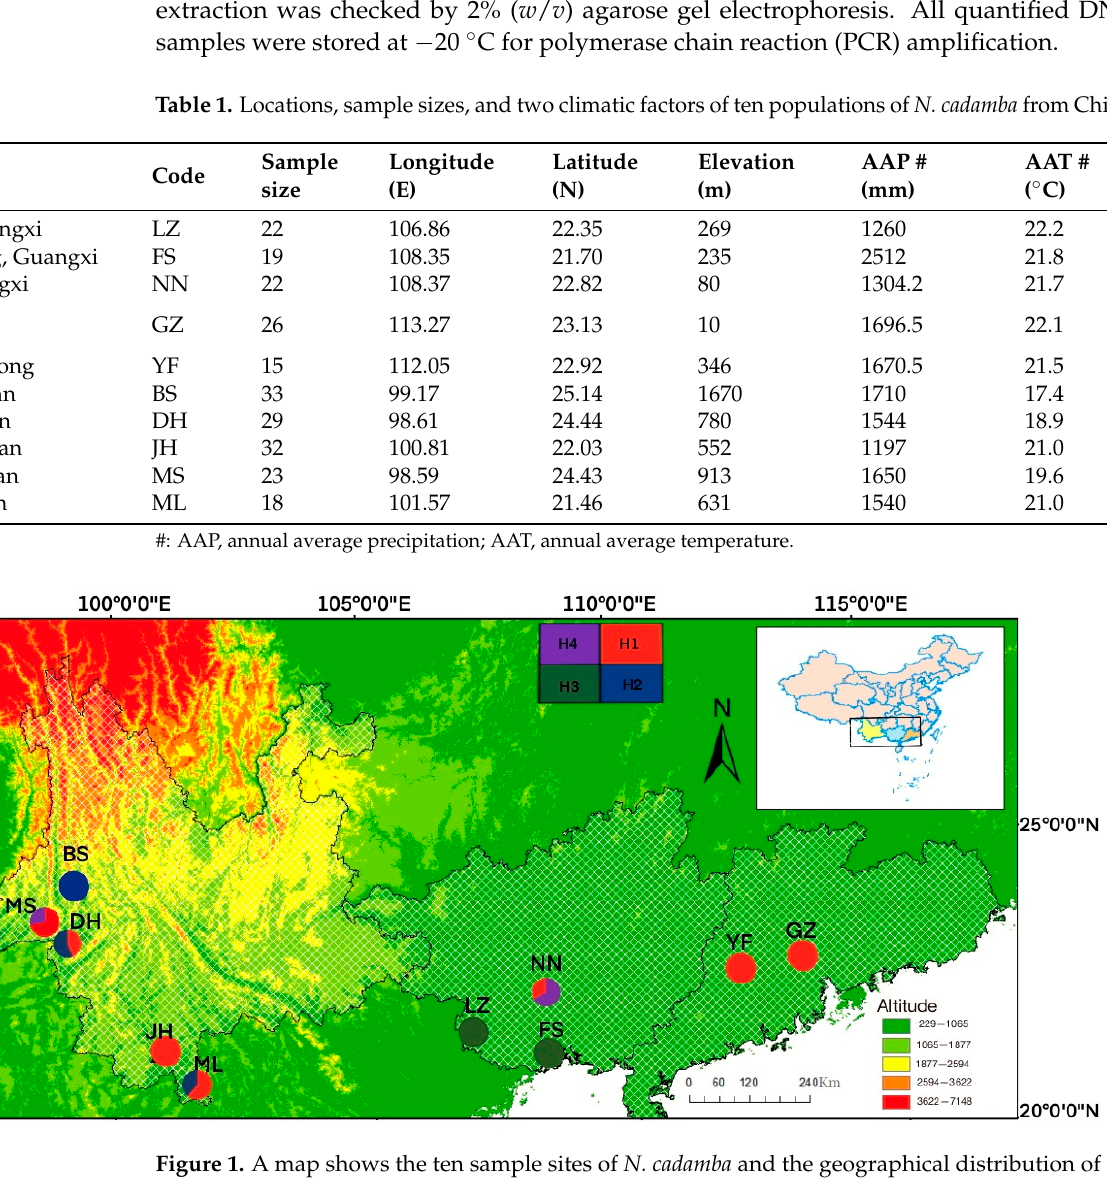
Figure 1. A map shows the ten sample sites of N. cadamba and the geographical distribution of the mtDNA haplotypes that were obtained from the concatenated sequences amplified by primers F1-R1 and F2-R2. The pie charts show the proportion of each haplotype in the ten populations. Each color in the pie chart represents one haplotype. H i ( i = 1,2,3,4) represents the i th haplotype